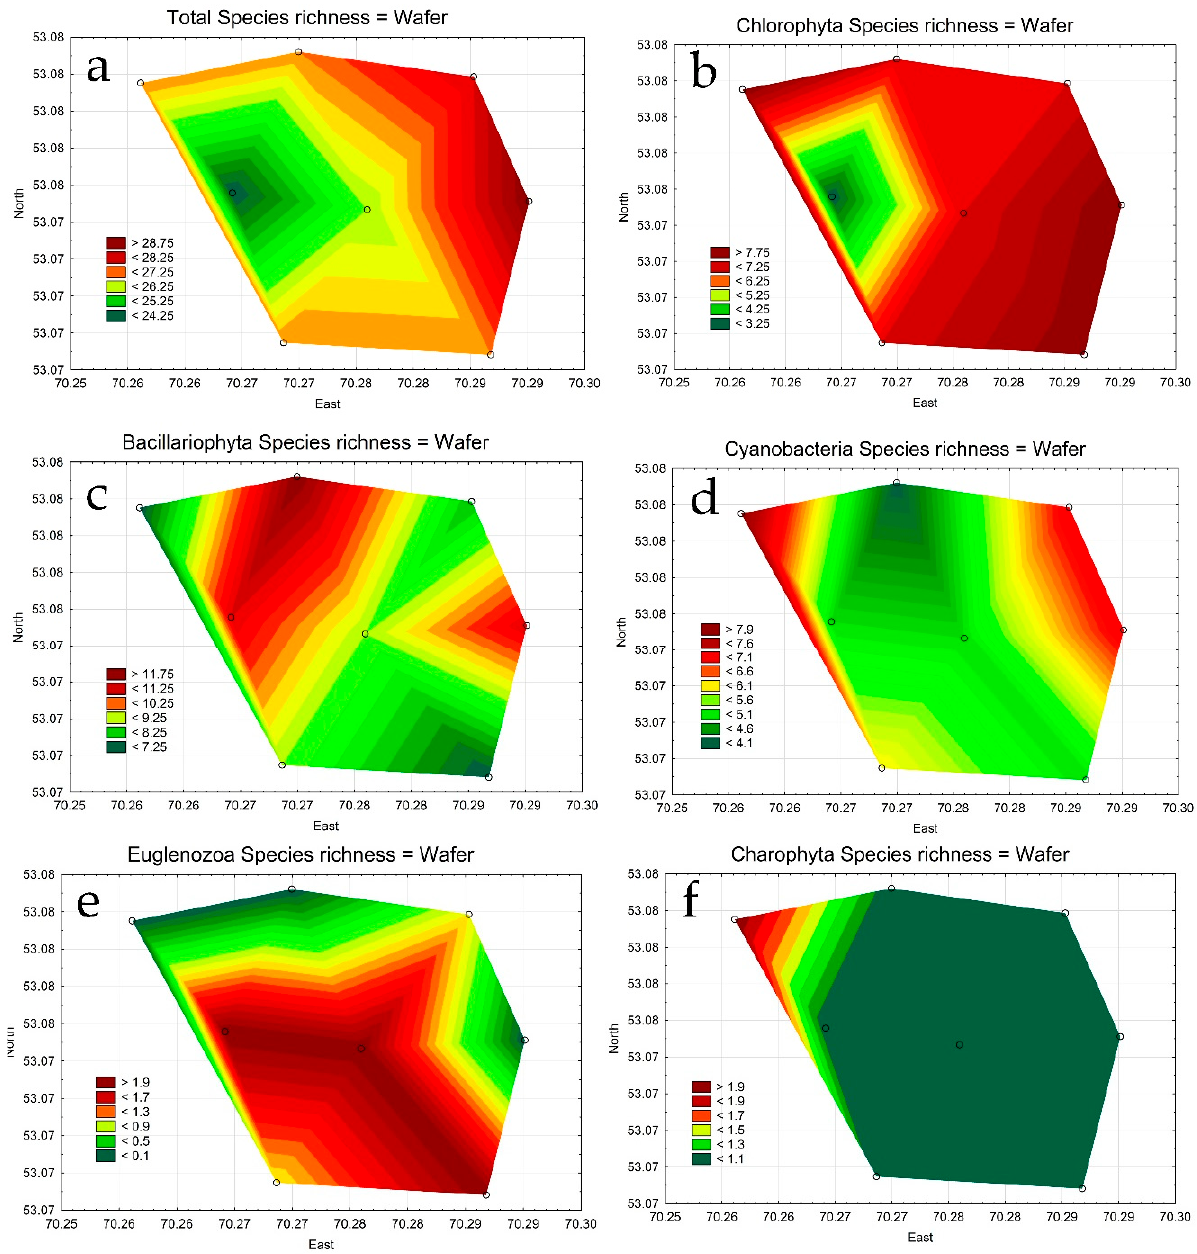
Figure 5. Statistical maps of distribution of phyla species richness in phytoplankton communities on the sampling stations of the Lake Borovoe surface, 2019. Total species richness ( a ), Chlorophyta ( b ), Bacillariophyta ( c ), Cyanobacteria ( d ), Euglenozoa ( e ), and Charophyta ( f ).